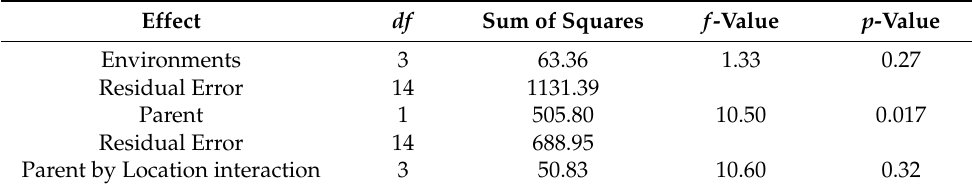
Table 1. Analysis of variance of Kunitz trypsin inhibitor concentration (KTI) between the two parents Glenn (normal KTI) and PI 547,656 (low KTI) planted in Blacksburg and Orange, VA in 2016 and 2017.